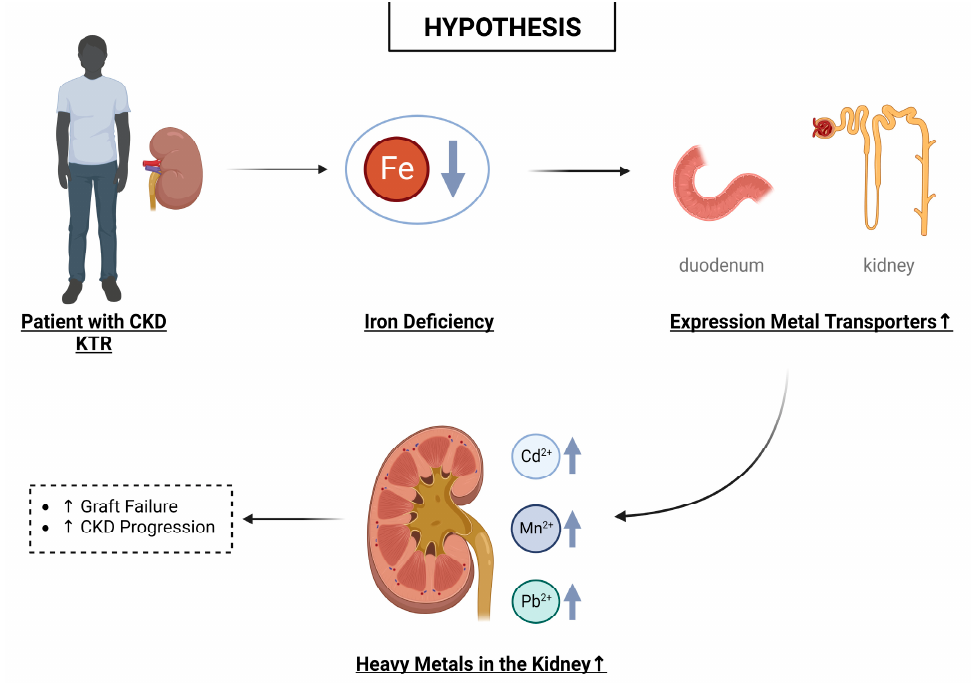
Figure 3. Overview of our hypothesis that iron deficiency, which is common in kidney (transplant) patients, plays a role in the nephrotoxic effects of heavy metal exposure. CKD: chronic kidney disease. KTR: kidney transplant recipient. Created with BioRender.com.